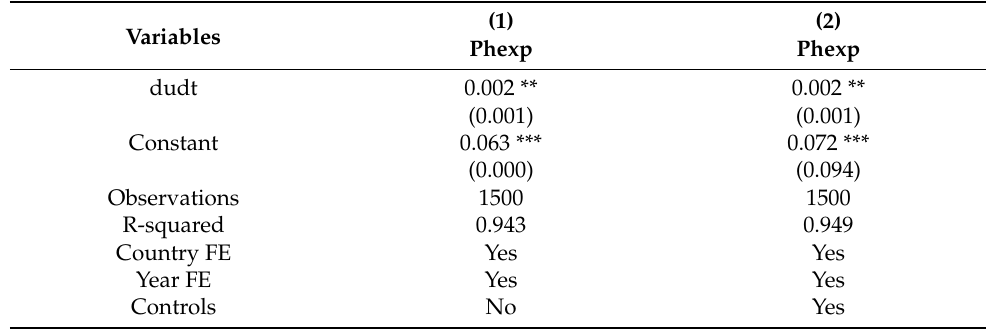
Table 8. The impact of the BRI on public health in the belt-road countries. (1) (2) Variables Phexp Phexp dudt 0.002 ** 0.002 ** (0.001) (0.001) Constant 0.063 *** 0.072 *** (0.000) (0.094) Observations 1500 1500 R-squared 0.943 0.949 Country